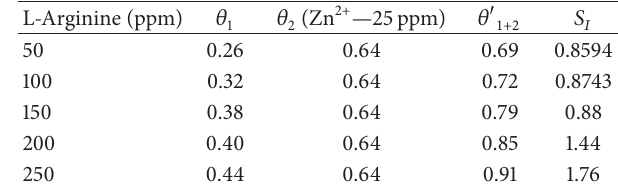
Table 3: Synergism parameter ( 𝑆 𝐼 ) for carbon steel immersed in sea water in the absence and presence of